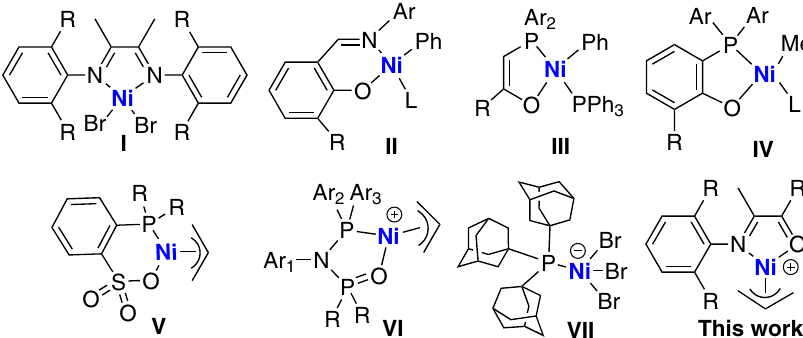
Fig. 1 Selected examples of nickel-based ethylene polymerization catalysts. Various high-performance ethylene (co)polymerization systems have been reported, with notable examples including α -diimine nickel catalysts ( I ), salicylaldimine nickel catalysts ( II ), SHOP-type nickel catalysts ( III ), phosphinophenolate nickel catalysts ( IV ), phosphine-sulfonate nickel catalysts ( V ), diphosphazane monoxide nickel catalysts ( VI ), and triadamantylphosphine nickel catalysts ( VII ). In this work, a simple but extremely versatile α -imino-ketone nickel system was